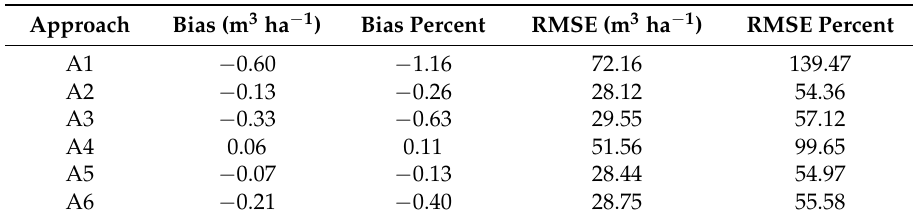
Table 5. Bias, bias percent, RMSE, and RMSE percent obtained from leave-one-out cross validation in estimating change in volume per hectare using different